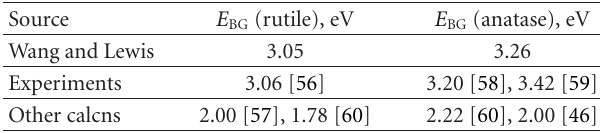
Table 1: Comparison of calculated band gaps of undoped rutile and anatase TiO 2 with experimental and calculated values reported by others ( E BG is the direct band gap). From Wang and Lewis